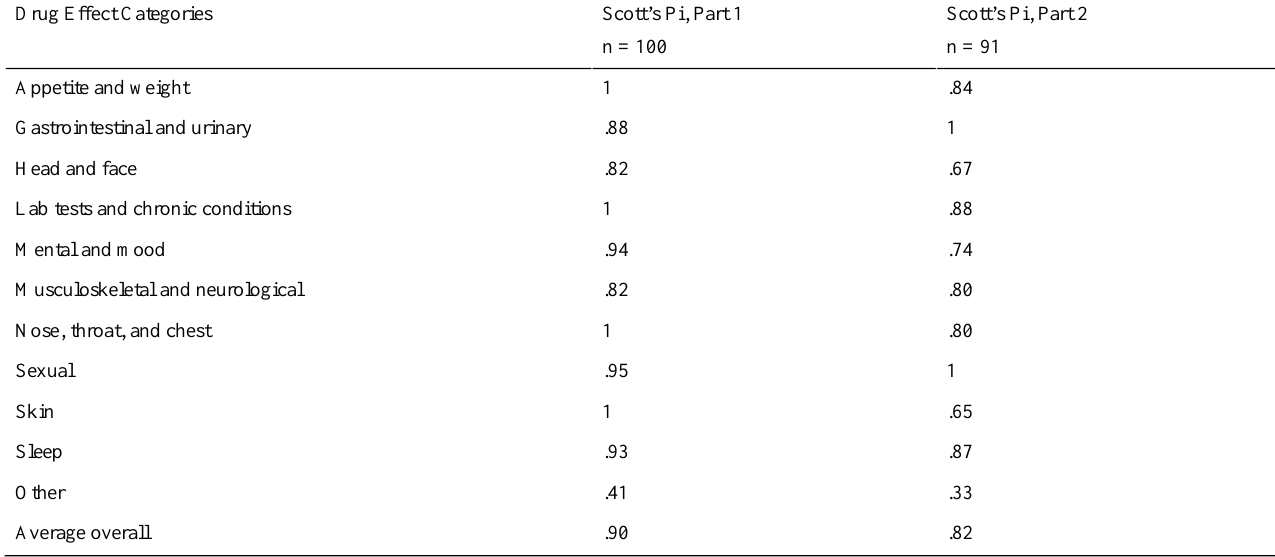
Table 4. Intercoder agreement